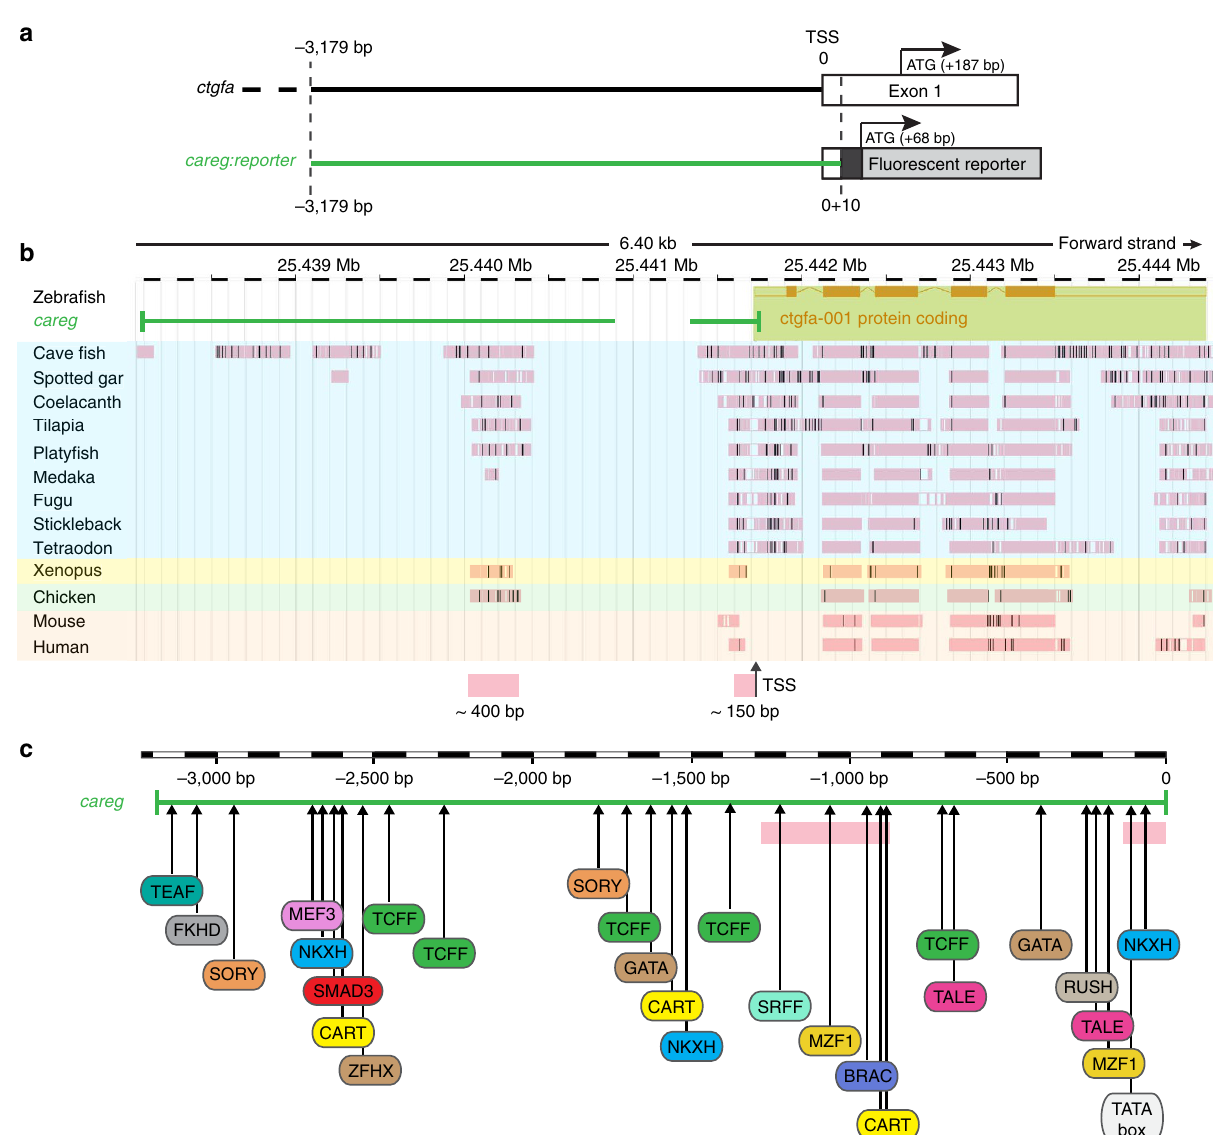
Figure 3 | Sequence analysis of the careg element. ( a ) Comparison of the careg element and the ctgfa genomic sequence of wild-type AB strain zebrafish, which was used to generate transgenic fish. The careg element includes a 3,179bp sequence immediately upstream of the transcriptional start site (TSS) and 10bp of the 5 0 -untranslated region of ctgfa . ( b ) LASTz net pairwise alignment of the ctgfa genomic region between Zebrafish ( Danio rerio , Ensembl version 87.10, Chromosome 20; 25 0 438 0 500 - 25 0 444 0 700) and 9 other fish species (highlighted in blue), Xenopus (yellow), chicken (green) and 2 mammals (orange). The pink boxes indicate the conserved regions in the majority of the species. Black and white bars within the pink boxes represent gaps in the alignments. The careg sequence is indicated with a green line above the alignment. The gap in the careg sequence corresponds to additional 465bp in the sequence from the Ensembl database. This sequence is absent in the genome of AB zebrafish strain. The scale bar indicates the genomic position in the chromosome 20 of zebrafish. Two conserved regions of B 400 and 150bp are indicated with pink boxes at the bottom of the alignment. ( c ) Prediction of transcription factor (TF) binding sites in the careg sequence (green) with MatInspector (Genomatix). The pink boxes indicate the conserved regions identified in b . A SMAD3 binding site is highlighted in red. The complete list of TF binding sites is given in Supplementary Data